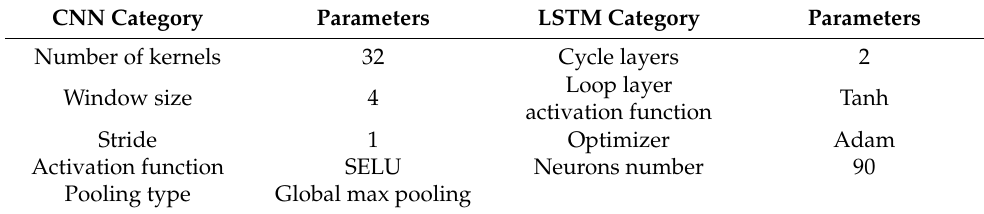
Table 6. Specific parameters of ConvLSTM